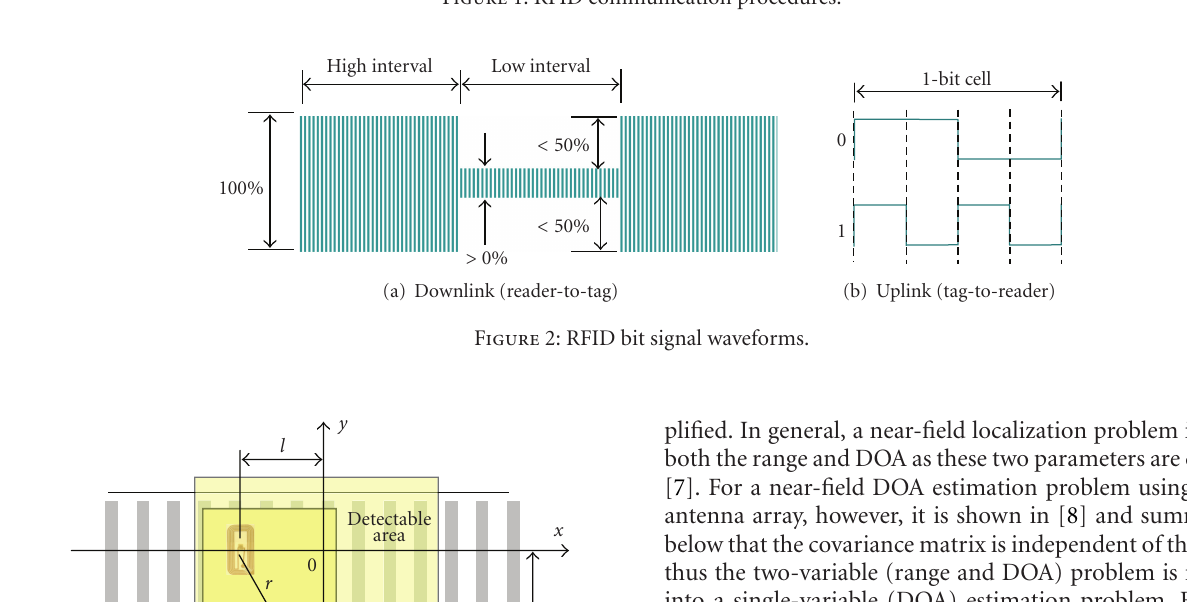
Figure 1: RFID communication procedures.